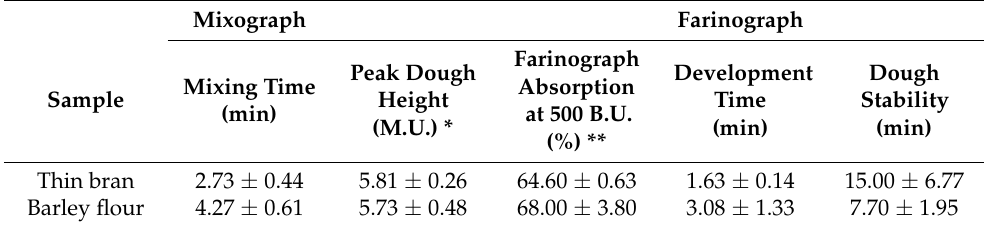
Table 5. Main technological parameters: two-factor ANOVA (analysis of variance) referred to the two flours: thin bran and barley flour (data are means ± standard deviations).